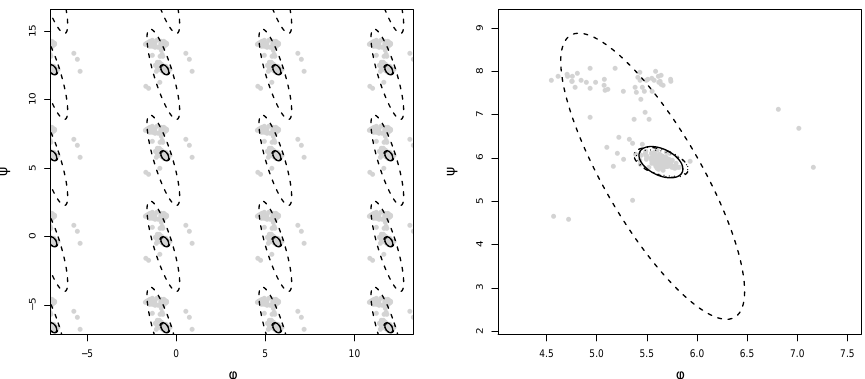
the arc between 3 π /2 and 7 π /4; outliers in the ψ dimension are mainly clustered close to π /2, far from the bulk of the data. Group-wise rose diagrams have been also added to highlight further the differences. Figure 9 shows a distance-distance plot, in which MLE-based Mahalanobis distances are plotted against their MCD based counterpart. The horizontal and vertical lines give the χ 2 cut-off. The inspection of the distance-distance 0.99,2 plot shows that the robust CEM detects at least a couple of sub-groups in the data that are largely hidden to maximum likelihood.